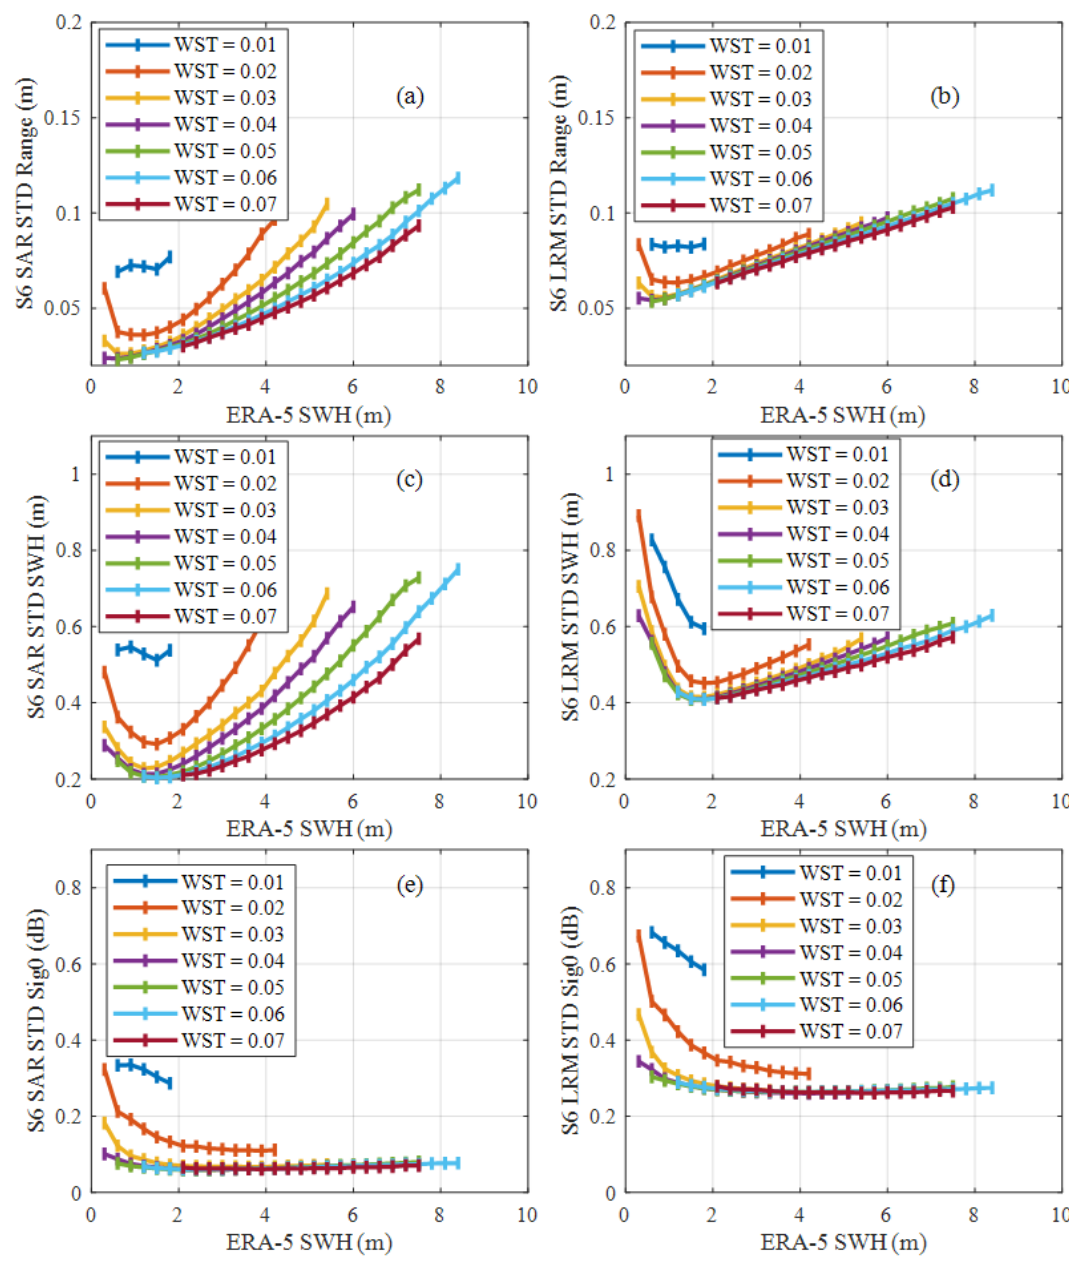
Figure 19. STD s of 20 Hz Sentinel-6 SARM ( left ) and LRM ( right ) range, SWH and sigma0 against ERA5 SWH estimates for seven different WST